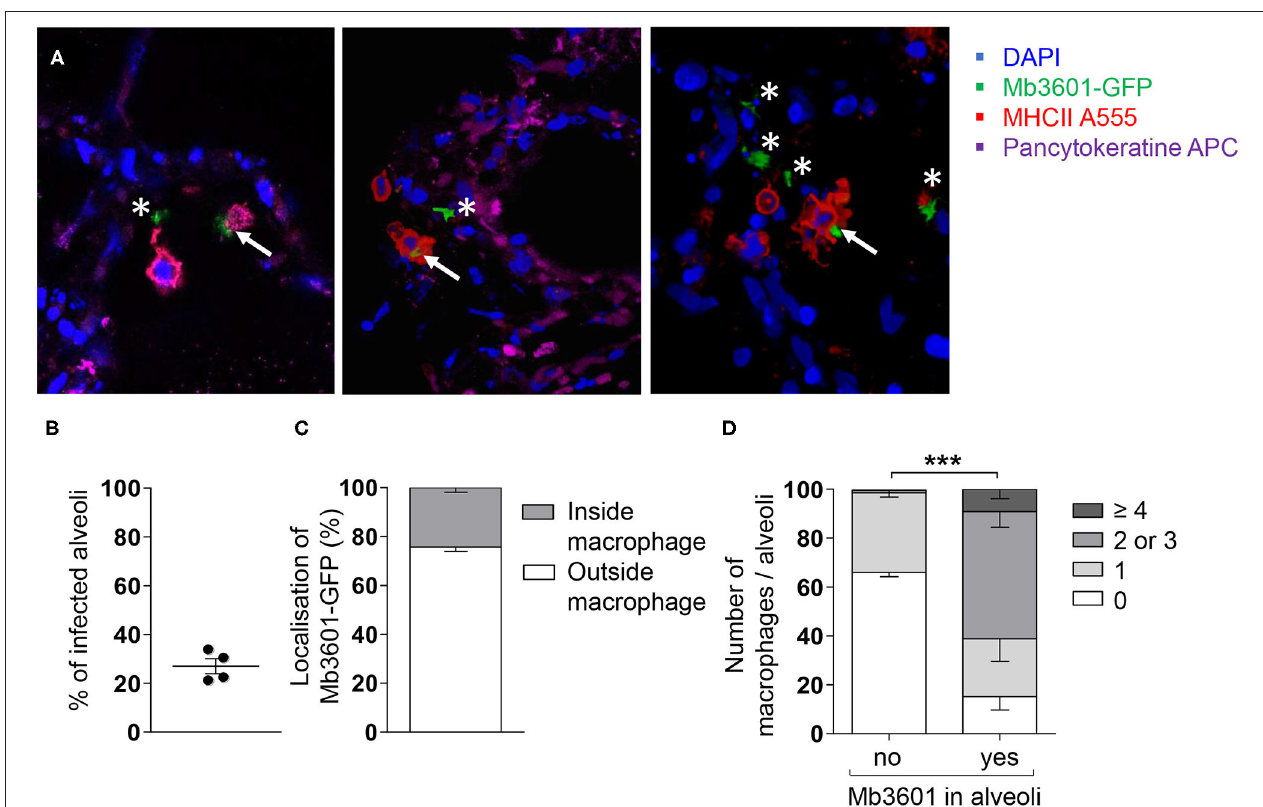
FIGURE 2 | Mb3601 is internalized by alveolar macrophages (AMPs) in the preserved lung structure from precision-cut lung slice (PCLS), and the infected alveoli contain higher numbers of AMPs compared to non-infected alveoli. The PCLS were infected with 10 5 colony-forming units of the green fluorescent protein Mb3601-GFP recombinant strain and fixed 2 days later. After labeling with anti-pancytokeratine (magenta) and anti-MHCII antibodies (Alexa 555, red), the PCLS were mounted with Fluoromount-G TM mounting medium containing DAPI (blue) and analyzed under a Leica confocal microscope (A) ; 3D images were analyzed with Leica LAS software. Z-stack imaging was performed at × 63 enlargement (10–15 µ m in thickness, step size of 0.5–1 µ m). The white asterisks indicate extracellular bacilli, and the white arrows indicate bacilli inside MHC-II pos AMPs. (B) The graph represents the percentage of infected alveoli per PCLS among the 55–80 alveoli that were observed under the microscope ( n = 4 PCLS from two different Blonde d’Aquitaine cattle). (C) Stack histogram of the mean percentage ± SEM of intra- or extracellular bacilli among a minimum of 15 infected alveoli that were observed ( N = 4 PCLS). (D) The number of MHC-II pos AMPs per alveoli was counted in infected or non-infected alveoli. The data presented as percent are the mean ± SEM of n = 4 PCLS from two different Blonde d’Aquitaine cattle. Between 55 and 80 alveoli were observed to obtain these data (two-way ANOVA, *** p <